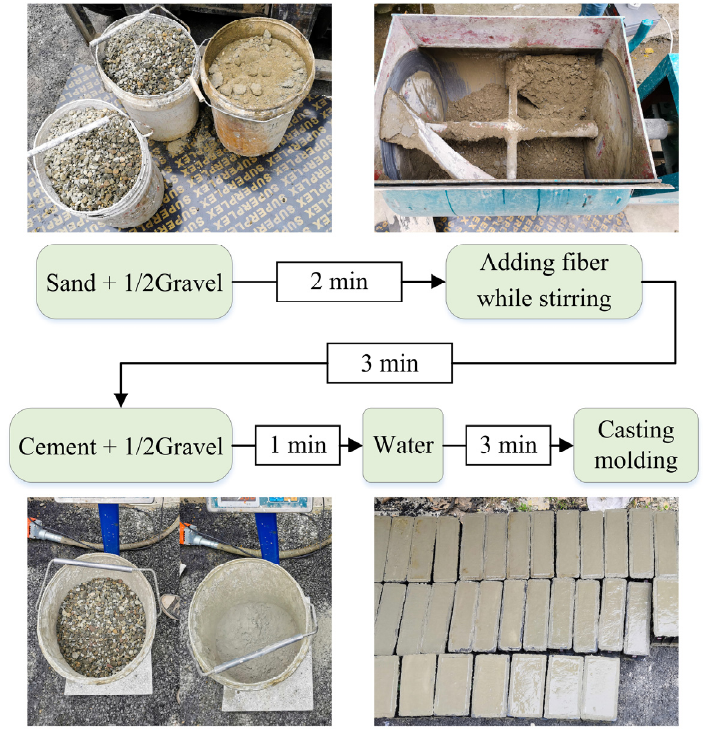
Figure 2. Flow chart of specimen pouring. Table 3. Grouping and numbering of specimens under normal temperature conditions.